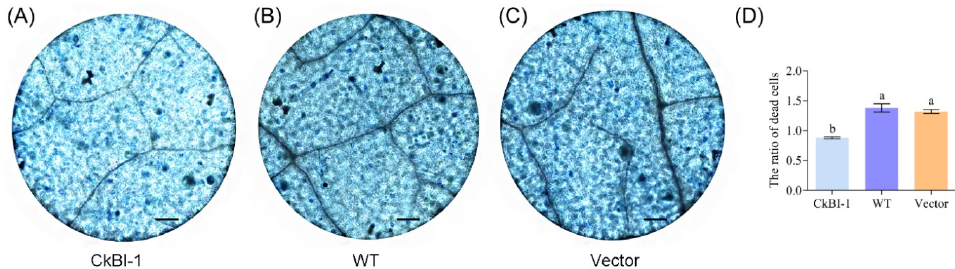
Figure 4. Trypan blue staining of tobacco CkBI-1 -OE line leaves. ( A ) CkBI-1 -OE line. ( B ) WT. ( C ) Empty vector. ( D ) Analysis of the degree of trypan blue staining. Data are shown as the mean ± SD of three independent experiments. One-way ANOVA was performed for the statistical analysis, where different letters represent significant differences ( p < 0.05). Scale bars, 100 µ m.